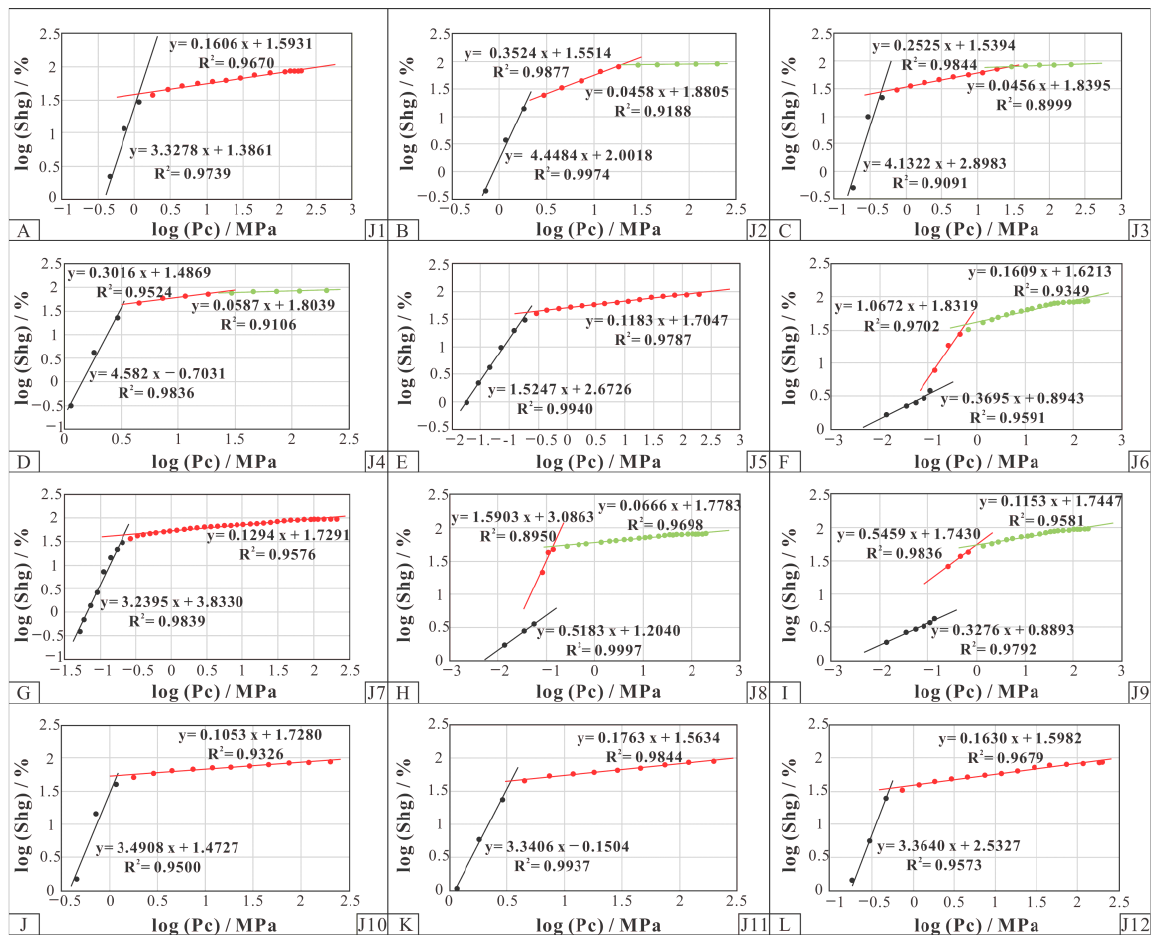
Figure 9. Fractal distribution derived from HPMI for the 12 typical samples. Figures ( A – L ) represent 12 samples from J1 to J12 respectively.